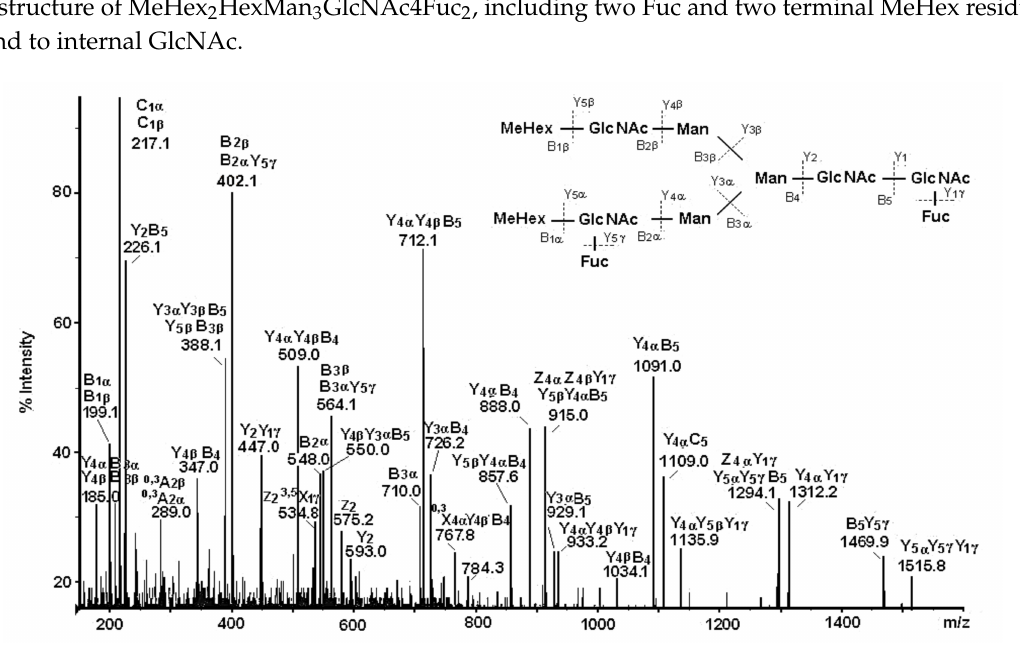
Figure 12. MS / MS spectrum of HtH1 glycan represented by ion with m / z 1002.8 [M + 2Na] 2 + and complex carbohydrate structure